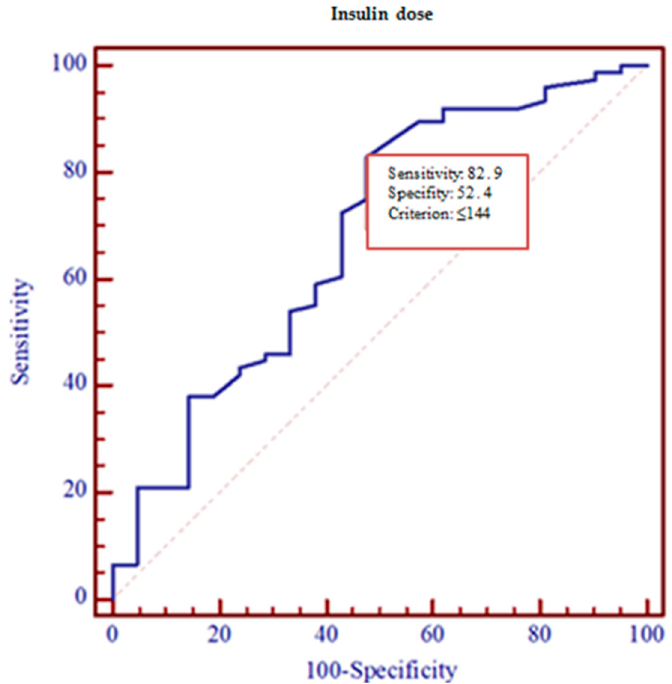
Figure 4. ROC curve for the highest MIC risk.